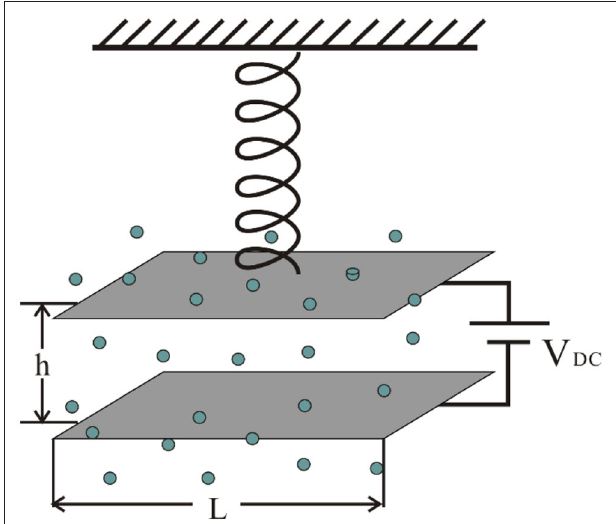
FIGURE 1 | Graphene MEMS in the porous medium.